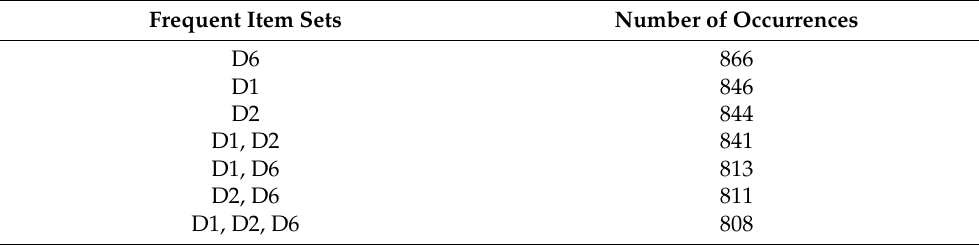
Table 4. The frequent item sets of the system.